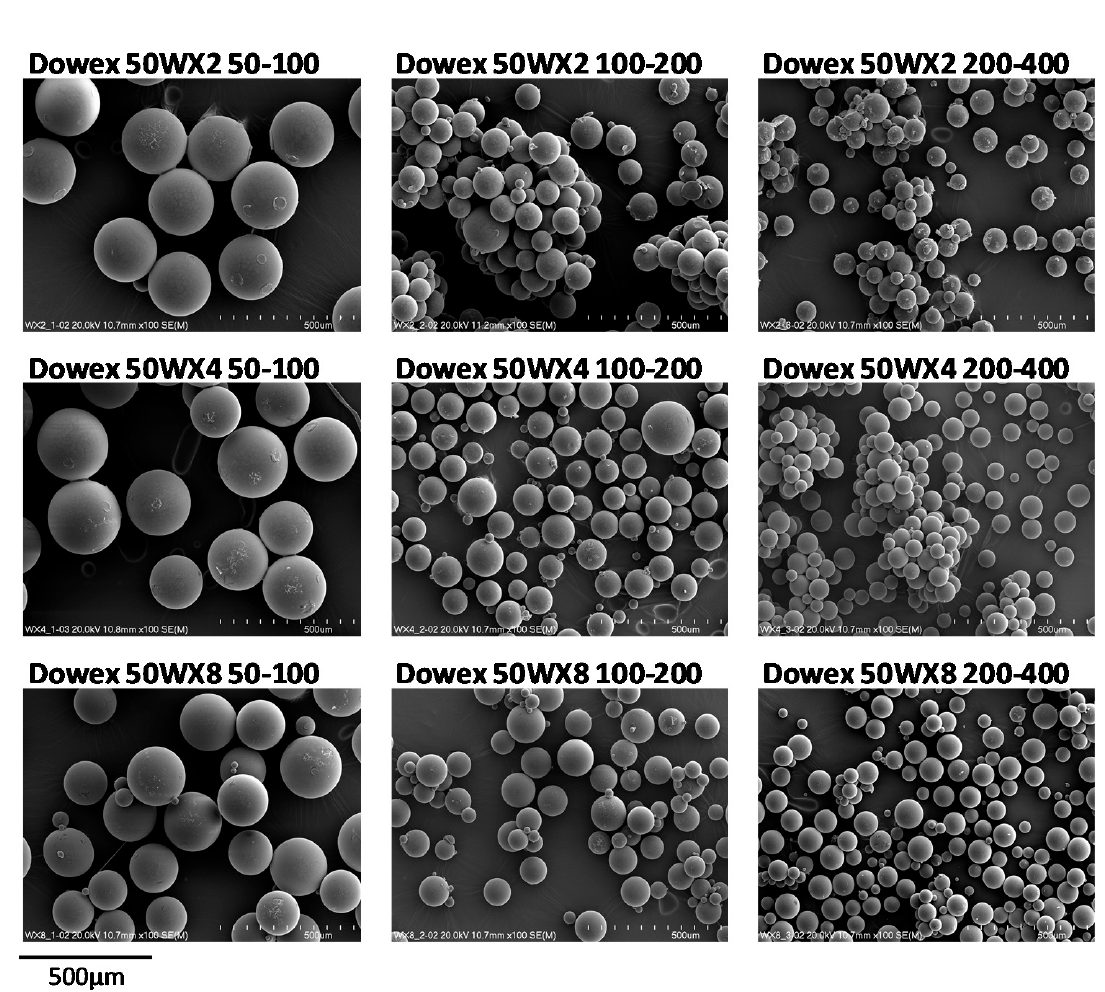
Figure 3. SEM micrographs of Dowex ion exchange resins.